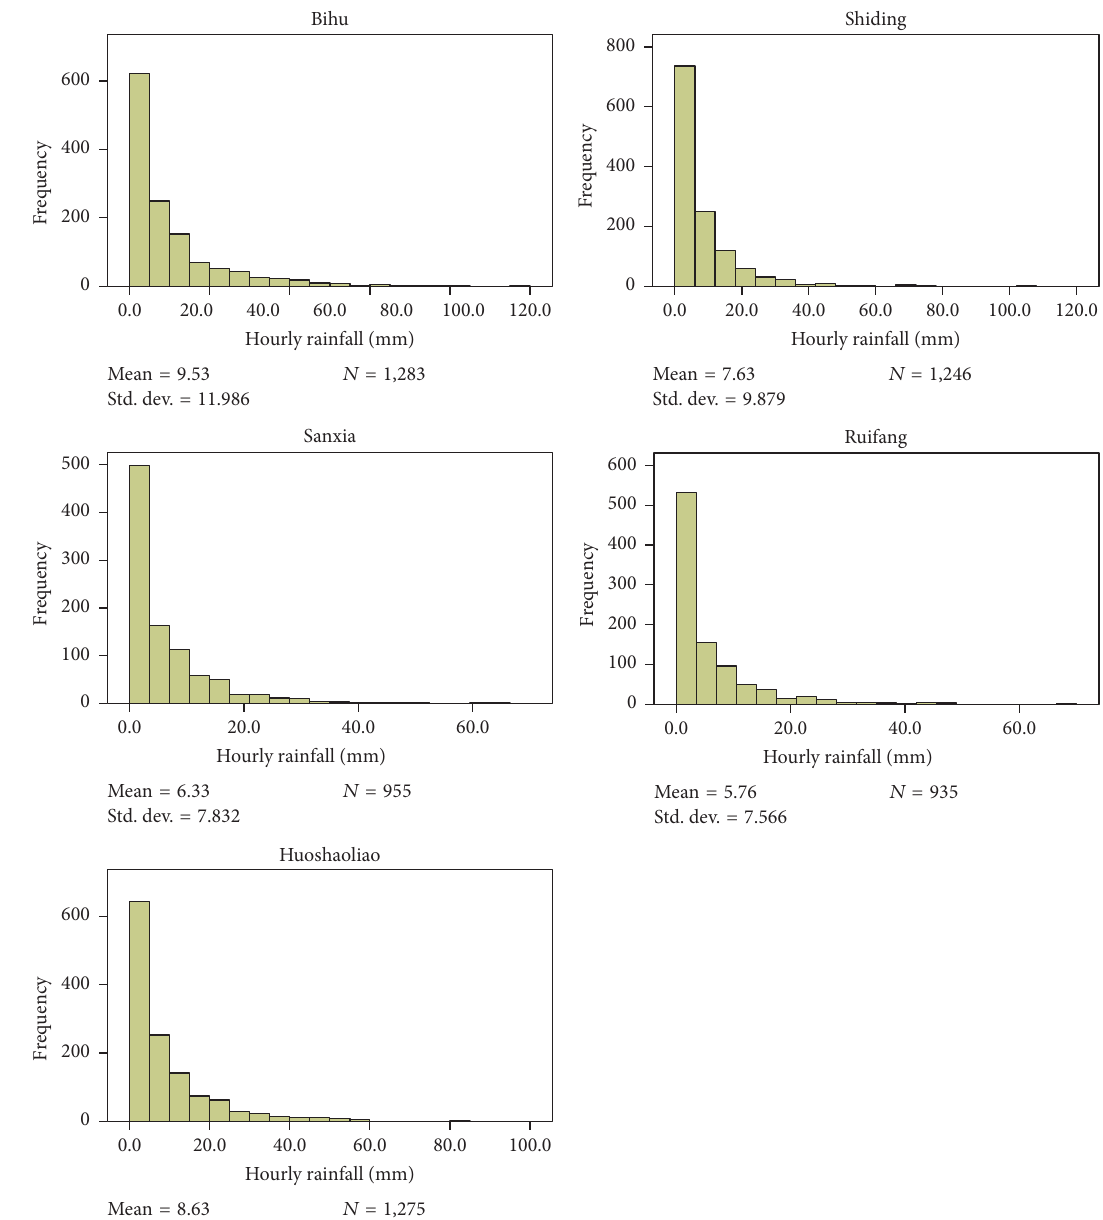
Figure 2: Frequency diagrams and information of hourly rainfall of the rain gages in Tamsui River Basin during typhoon events.